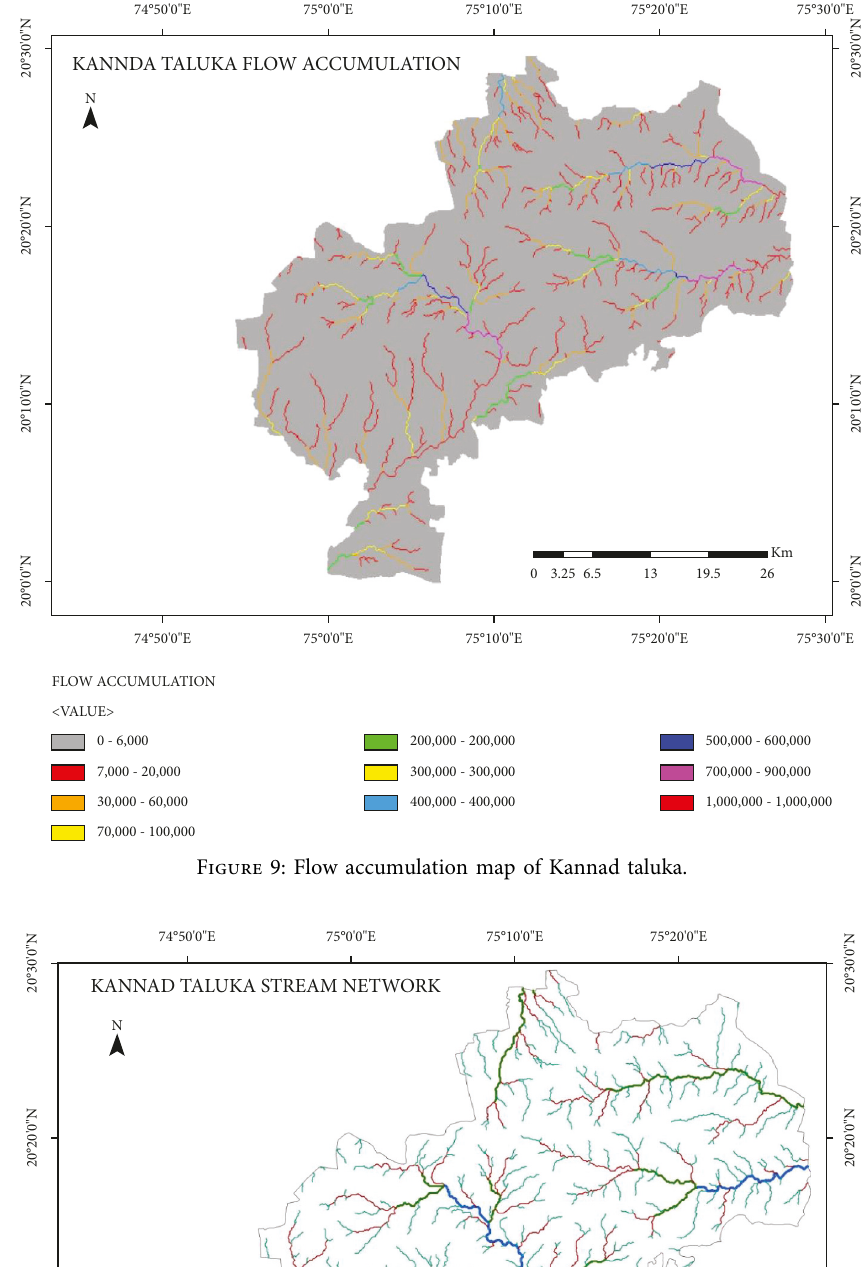
Figure 10: Stream network map of Kannad